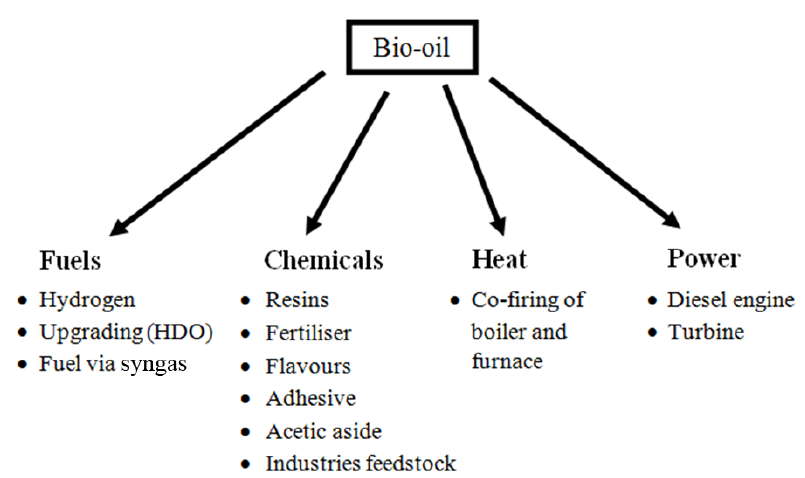
Figure 7. Various applications of pyrolysis